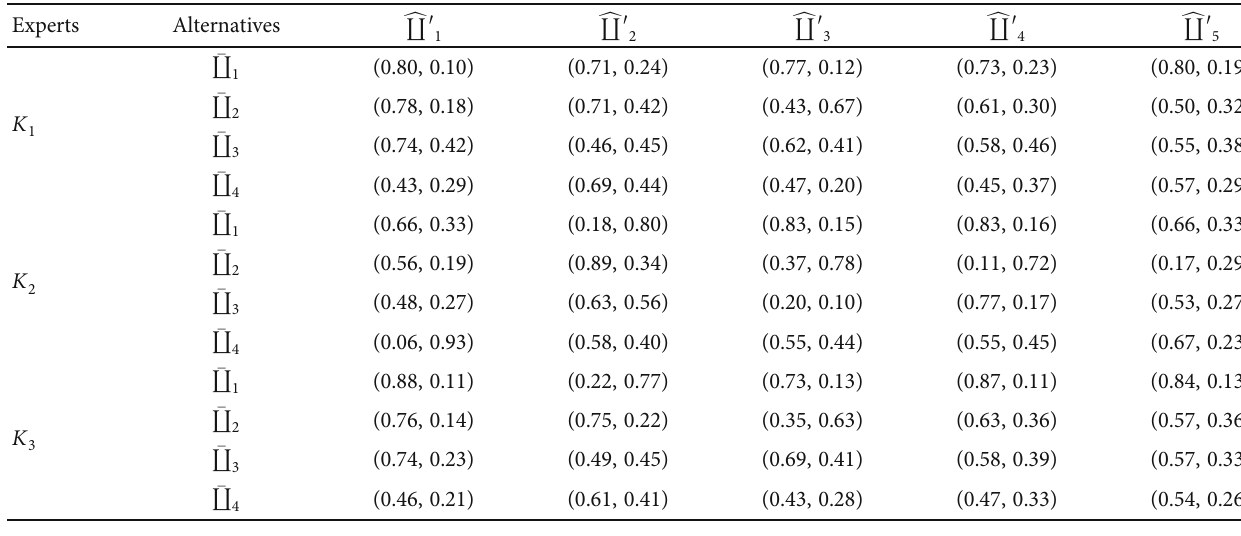
Table 2: Normalized IF decision